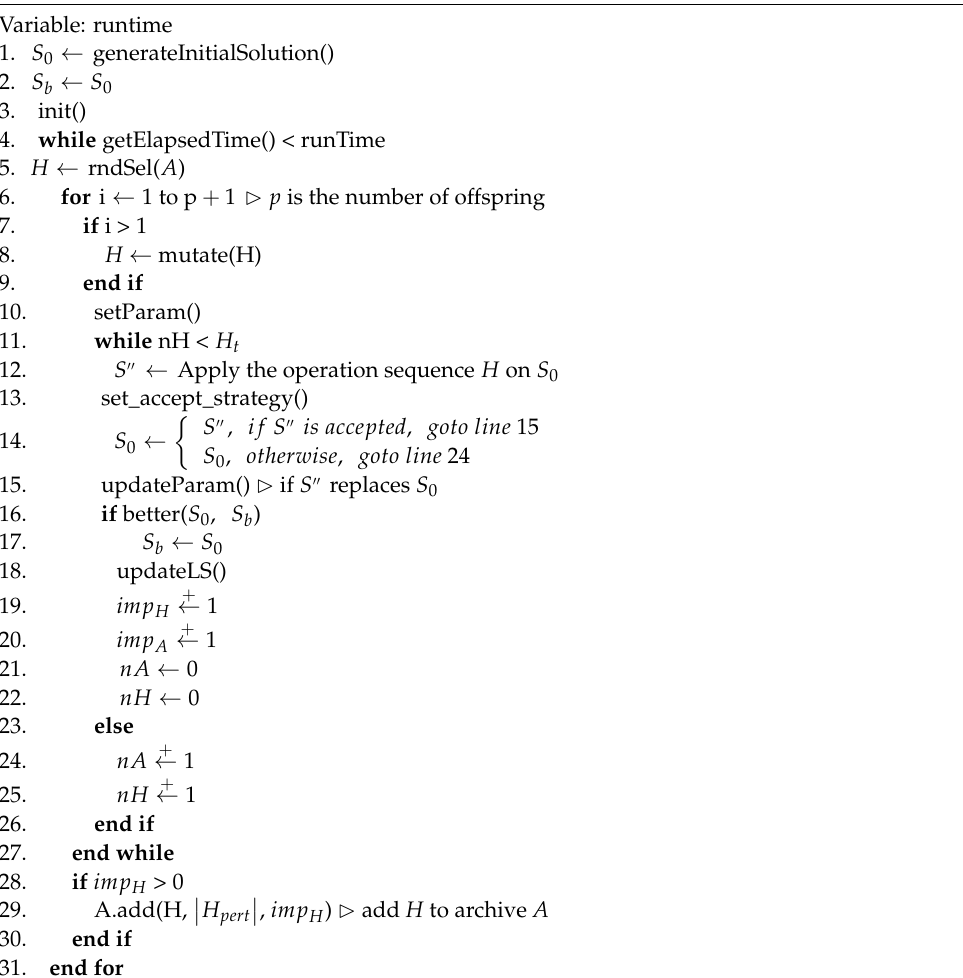
Algorithm 2: The EA-ILS